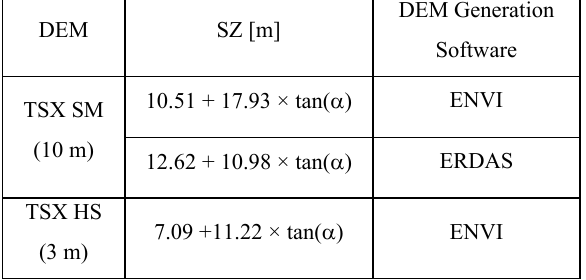
Table 4. Accuracy assessment of DEMs (SZ= Standard deviation of Z differences in comparison